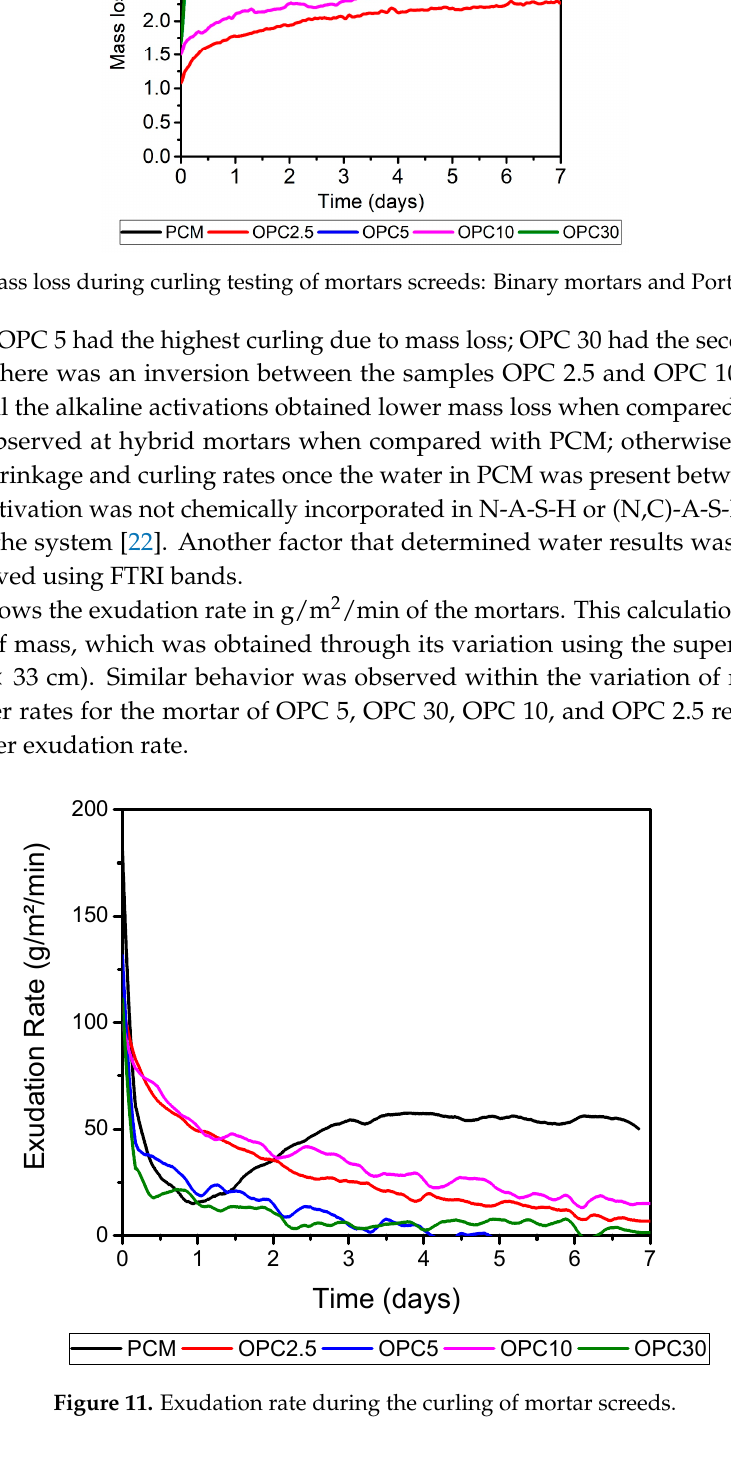
Average Figure 9. Curling over the time for Portland cement mortars screeds. We observed a difference in the curling of mortars when comparing cement compositions, specifically between mixes with a 10% of cement compositions and OPC. A maximum warpage obtained for these samples occurred on the first day, bearing in mind that the temperature gradient was high inside the screeds until it reached the surface. Following this rapid water evaporation, probable micro internal cracks appeared in these alkaline-activated mortars with low cement content. These micro cracks served as warping compensators, resulting in the reduction of the lifting of the